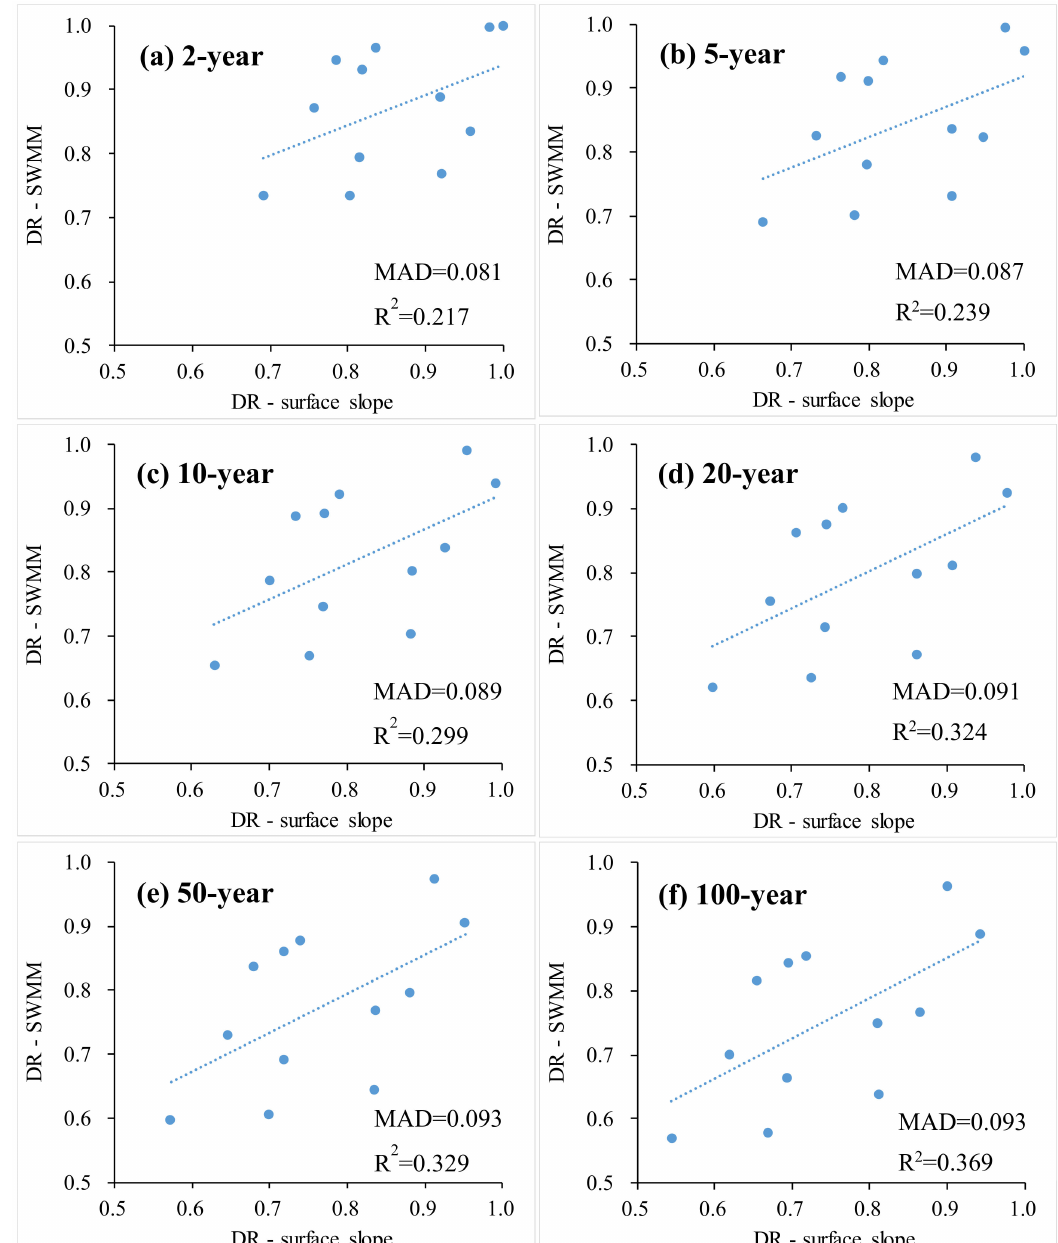
Figure 5. The scatter plots between the DR estimated by the regression models using VR s and by the SWMM in the 12 networks for the six typical rainfall